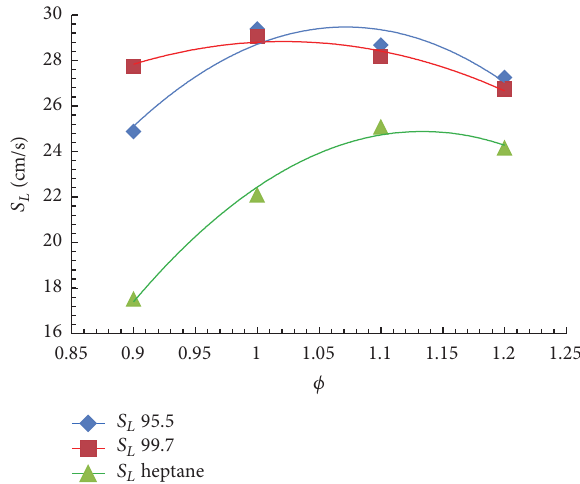
Figure 5: Laminar burning velocity of hydrous ethanol, anhydrous ethanol, and n-heptane fuels.